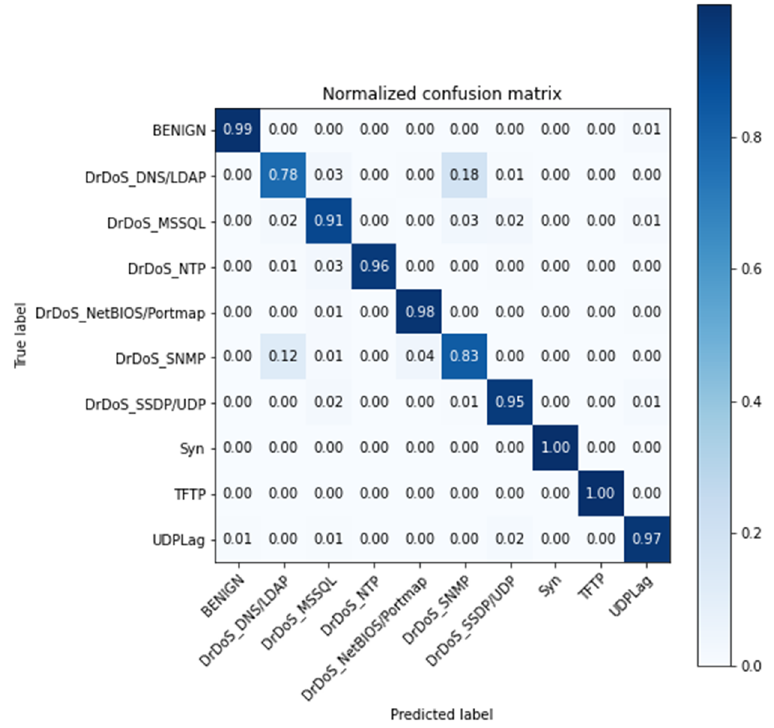
Table 8. Model training results for the third scenario.